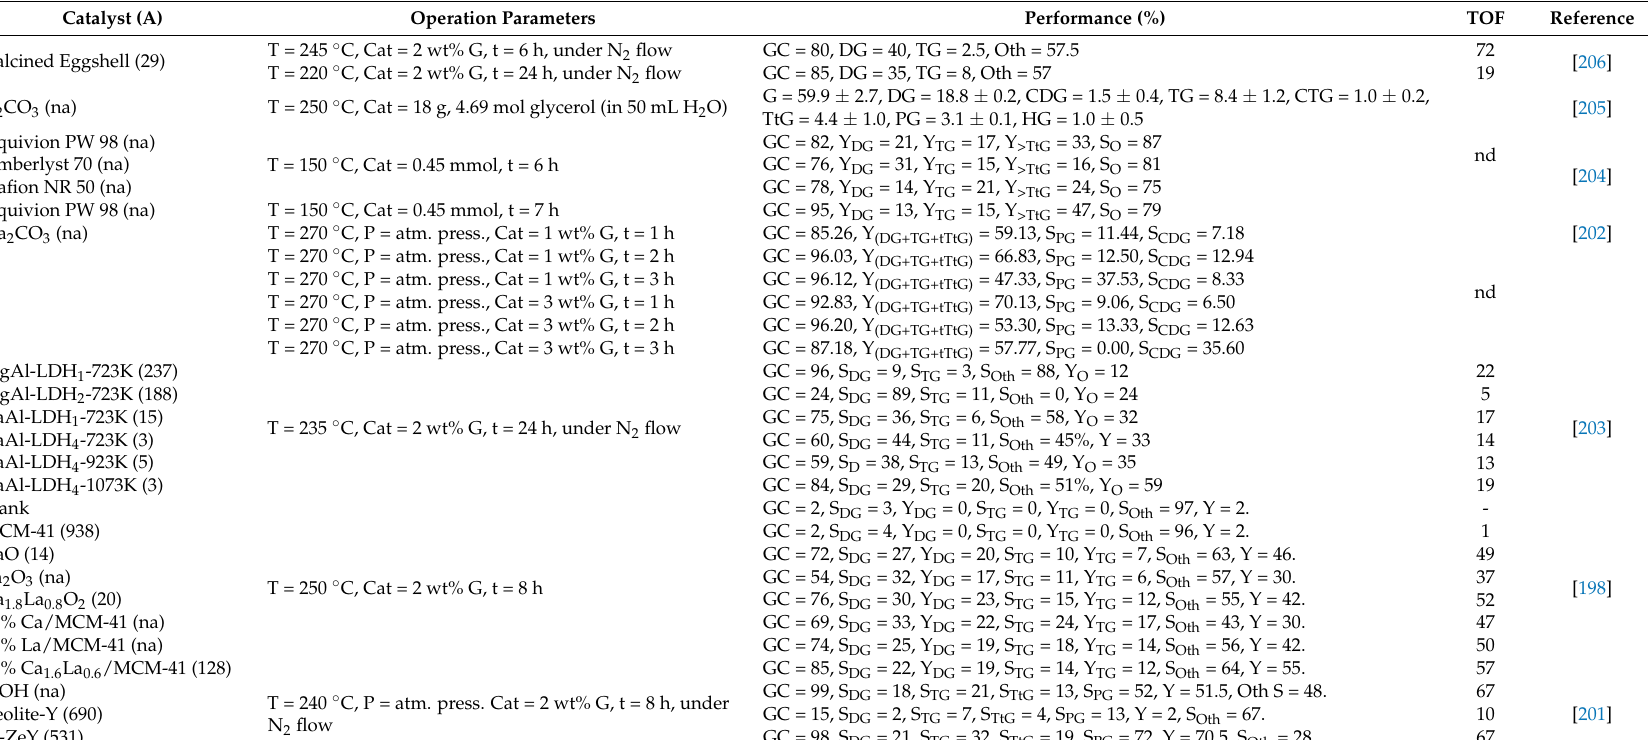
Table 14. Performance of some catalysts in the conversion of glycerol to polyglycerol as reported in some